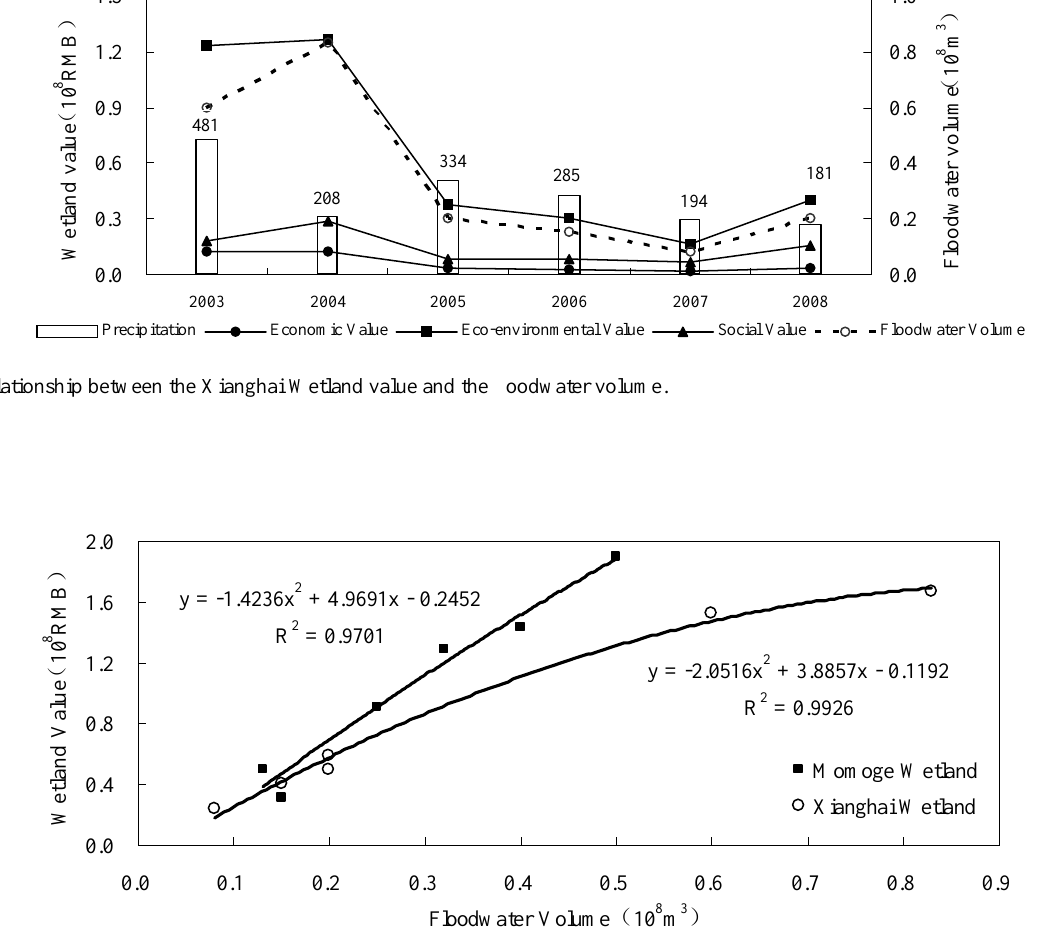
F Fig. 4. Fitting curve of wetland value versus floodwater